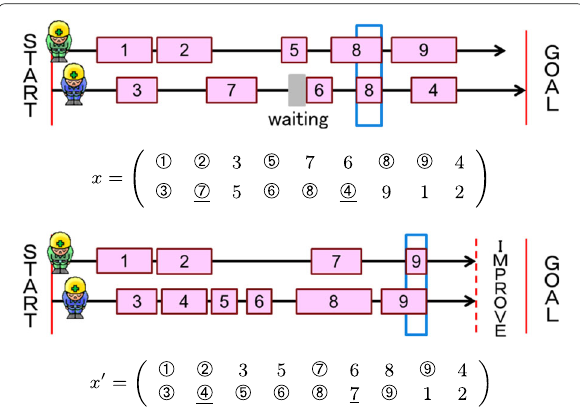
Fig. 5 An example of an improvement from an intra-swap